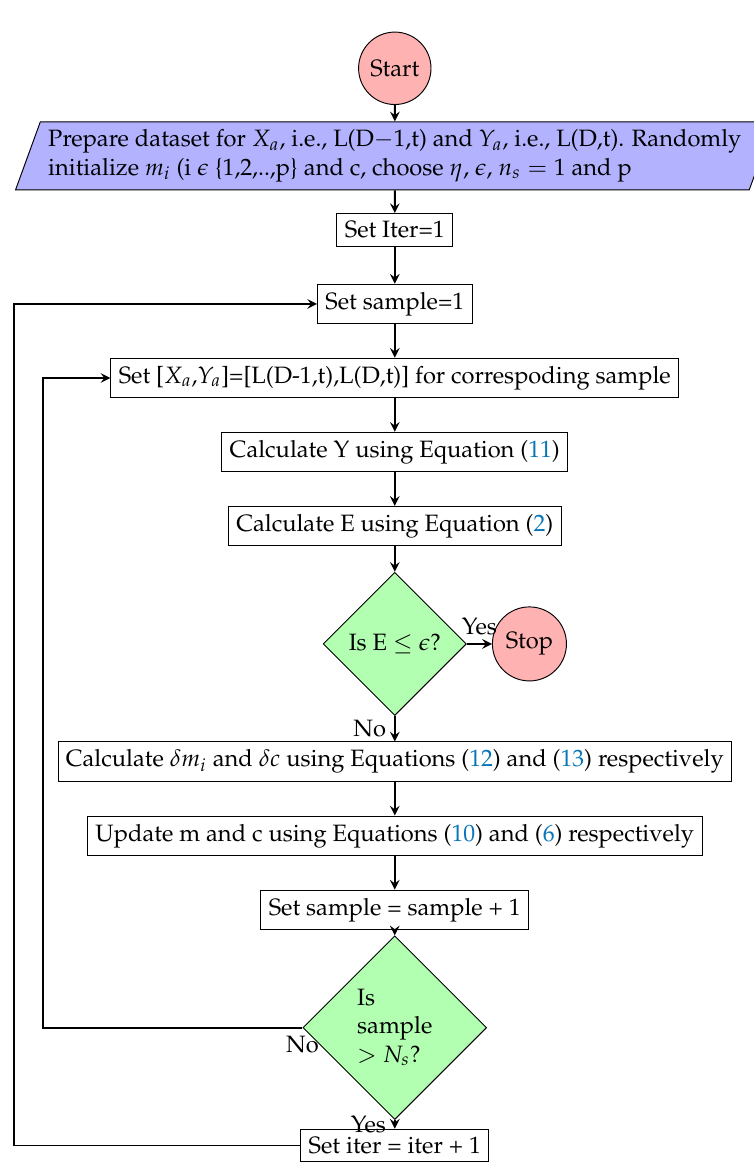
Figure 7. Polynomial Regression model training